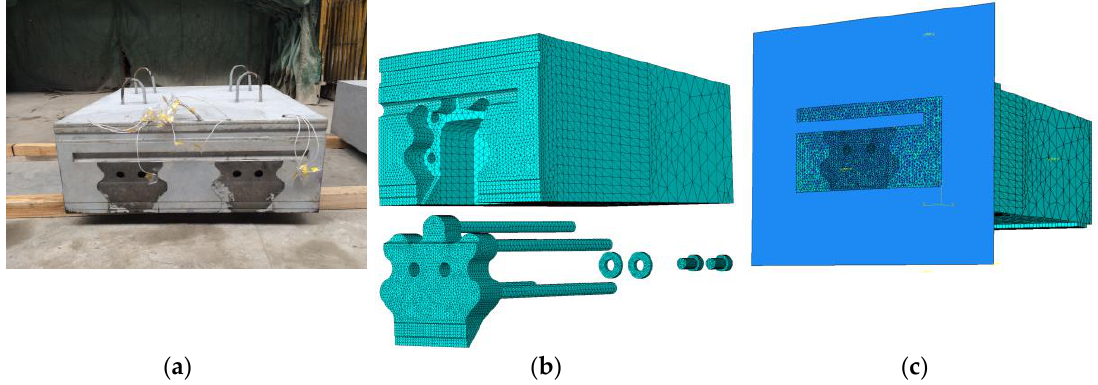
Figure A3. Tested joint segment and joint 3D model: ( a ) tested joint segment; ( b ) half of the concrete segment, embedded part, bolts and bolting pads; ( c ) model after assembly.